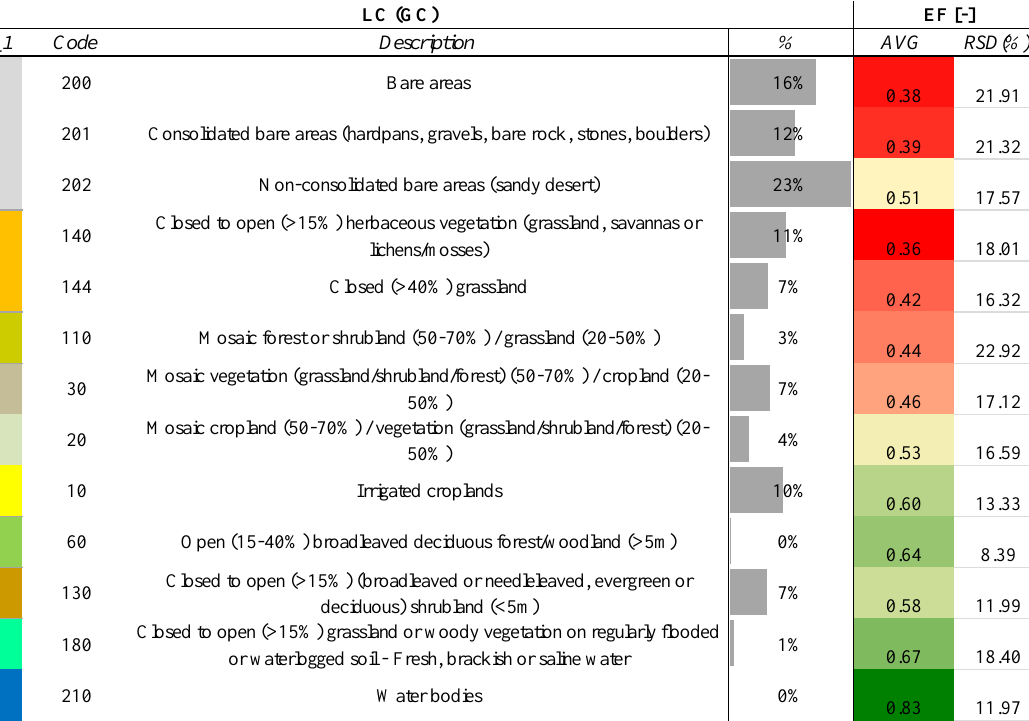
Figure 6. Percentage of GC classes over the study area (codes and map color are reported) and the statistics of EF data for each LC classes (average (AVG) and relative standard deviation (RSD)). Red and green indicate land cover with a lower of a higher EF average,